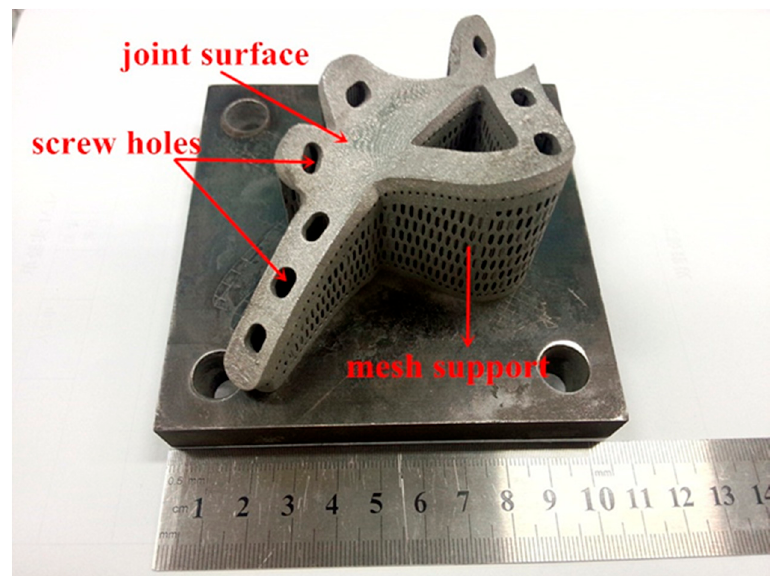
Figure 6. Customized bone plate after SLM fabrication.